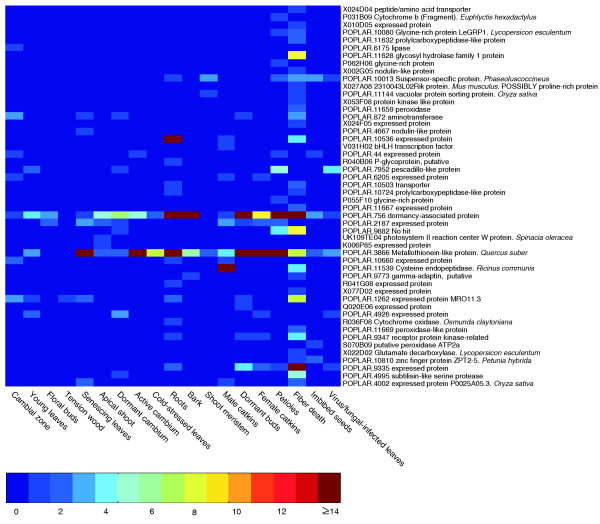
Gene expression in the 25K Populus cDNA array and in the POPULUSDB. The 50 most highly expressed transcripts in the microarray analysis of xylem fibers undergoing cell death are shown together with the corresponding library distribution in POPULUSDB. The transcripts are listed in descending order of expression ratio between the fiber-cell death sample and the early fiber development sample (see Figure 1). The color code at the bottom of the figure indicates the number of ESTs in each library for each transcript. The whole list is given in Additional data file 2.